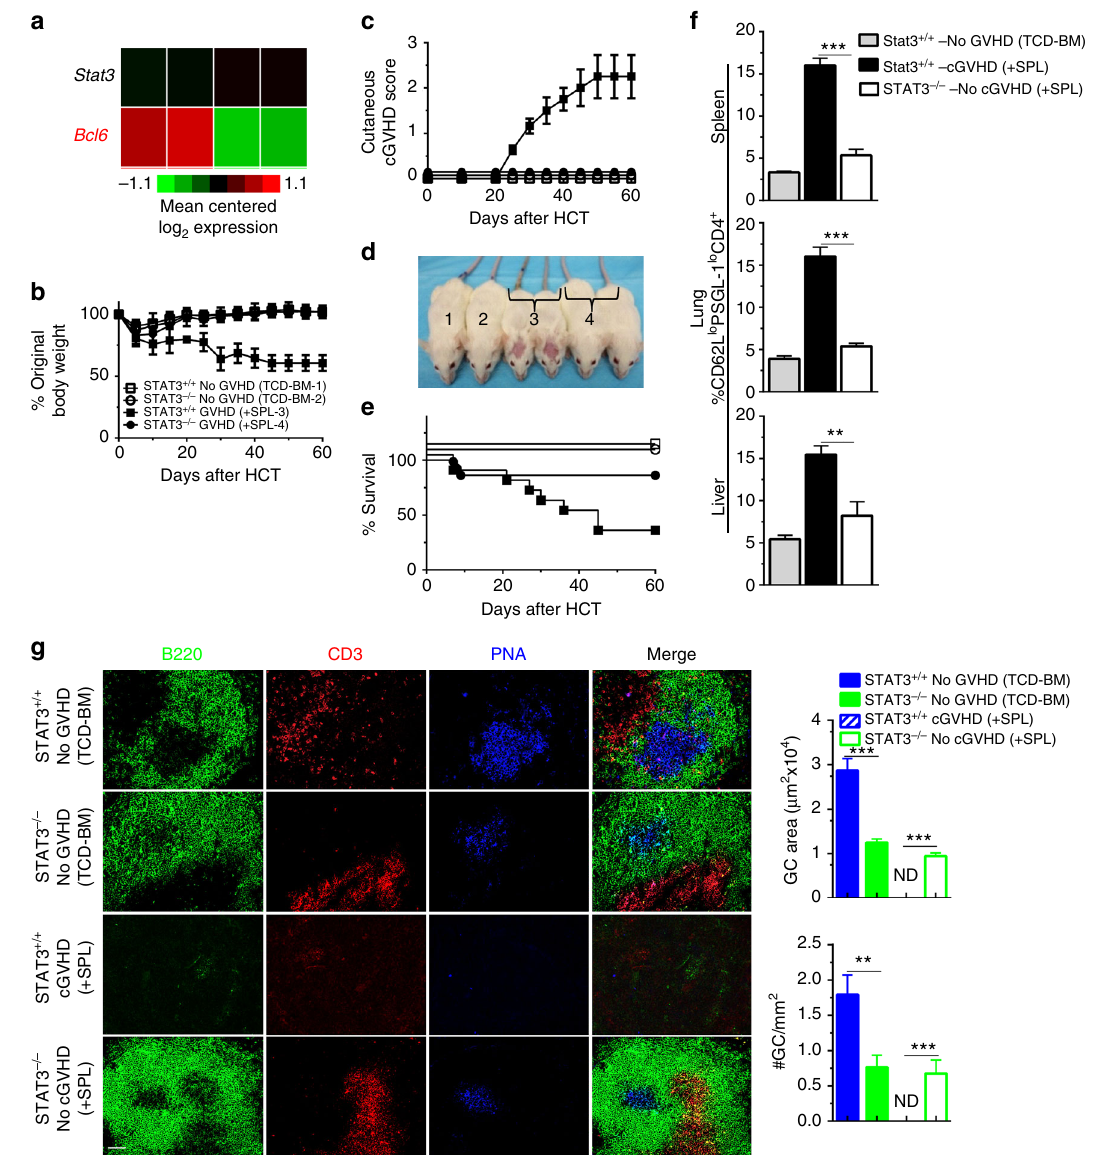
Fig. 7 Stat3 de fi ciency in donor CD4 + T cells prevents expansion of PSGL-1 lo CD4 + T cells and systemic cGVHD. a Twenty-one days after HCT, splenocytes from no-GVHD or cGVHD recipients given wild-type C57BL/6 donors were harvested and stained for CD4, CD44, PSGL-1, and CD62L. CD44 hi CD62L lo PSGL-1 lo CD4 + T cells were sorted and used for RNA isolation and RNA-Seq microarray analysis. Heat maps of RNA expression of transcription factor in extrafollicular T cells are shown as mean centered log 2 expression. RNA-Seq microarray measurements were performed on duplicate samples from no-GVHD and cGVHD groups. Each sample represents splenocytes from eight recipients. b – g BALB/c recipients were irradiated (850 cGy) and given 2.5 × 10 6 TCD-BM alone or 2.5 × 10 6 TCD-BM plus 1 × 10 6 splenocytes ( n = 12) from either WT or CD4-STAT3 − / − C57BL/6 donors. b Percent body weight changes (Group 3 versus Group 4: P < 0.001, two-way ANOVA). c Cutaneous cGVHD scores (Group 3 versus Group 4: P < 0.001, two-way ANOVA). d Picture taken on day 60 after HCT (1 and 3 – Stat3 +/+ – no GVHD and cGVHD, 2 and 4 – Stat3 − / − – no GVHD and cGVHD). e Survival curve (Group 3 versus Group 4: P < 0.05, log-rank test). f Twenty-one days after HCT, mononuclear cells from spleen, lung, and liver were stained with CD4, CD44, PSGL-1, and CD62L. Percentages of CD62L lo PSGL-1 lo cells among CD4 + CD44 hi are shown as mean ± SE ( n = 6). g Sixty days after transplantation, spleens were harvested and germinal centers were identi fi ed by immuno fl uorescent staining of B220, CD3, and PNA, and GC area and numbers were measured and are shown as mean ± SE ( n = 4). ** P < 0.01 *** P < 0.001, unpaired two-tailed Student ’ s t test. CD4-Stat3 +/+ no GVHD = CD4-Stat3 +/+